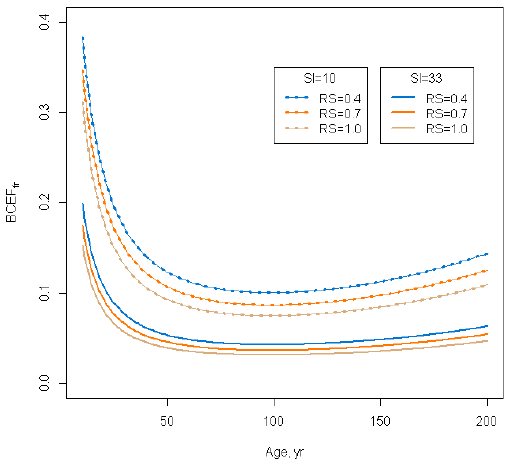
Figure 2. Biomass conversion and expansion factor for branches in European Russia southern taiga pine forests for different relative stocking values (0.4, 0.7 and 1.0) and site indexes SI (10 m, 33 m). We have used 983 sample plots in order to build the regression model.